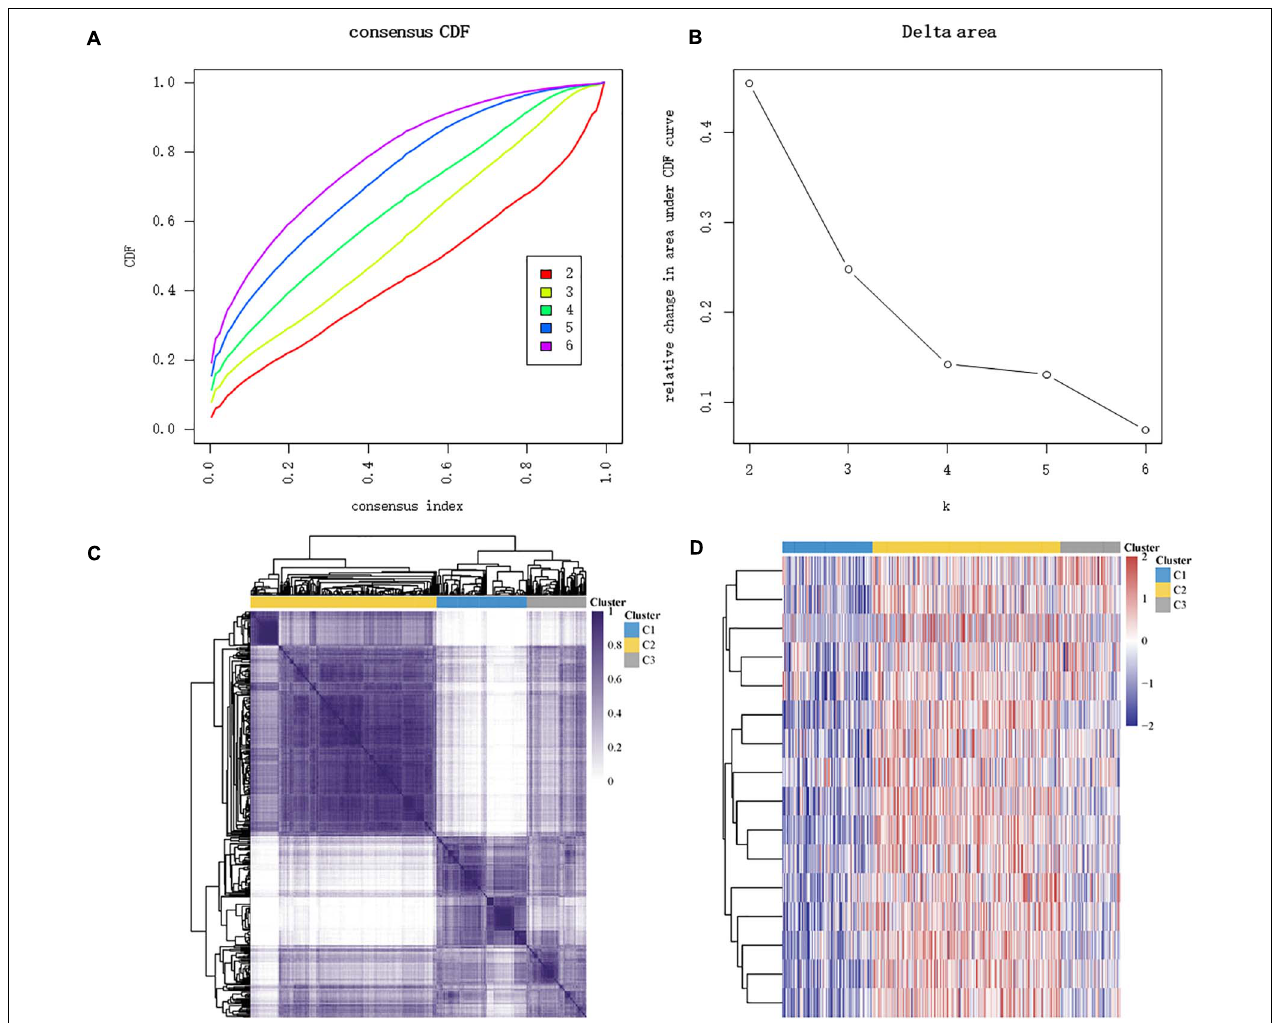
FIGURE 4 | Identification of consensus clusters according to the expression similarity of m6A-related genes. (A) Cumulative distribution function (CDF) ( k = 2–6). (B) Relative change in area under the CDF curve ( k = 2–6). (C) The matrix of consensus clustering ( k = 3). (D) Heat map of m6A-related gene expression in different subgroups; red represents high expression while blue represents low expression.